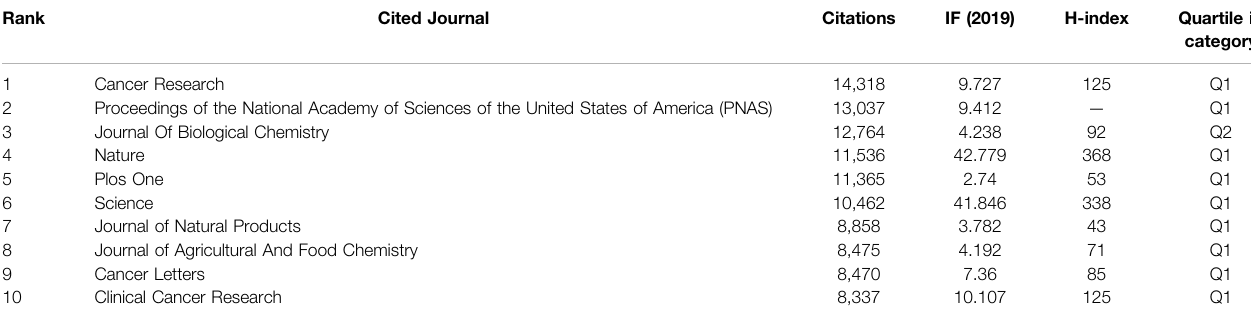
TABLE 4 | The top 10 co-cited journals related to natural products in cancer research.